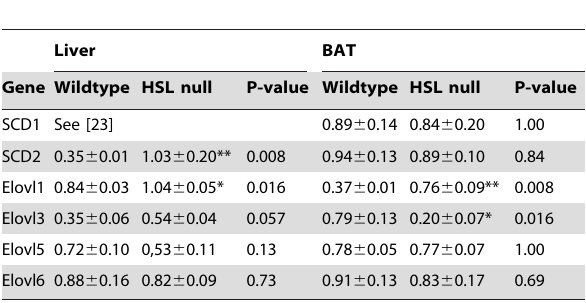
Table 1. Gene expression analysis in liver and BAT of wildtype and HSL null